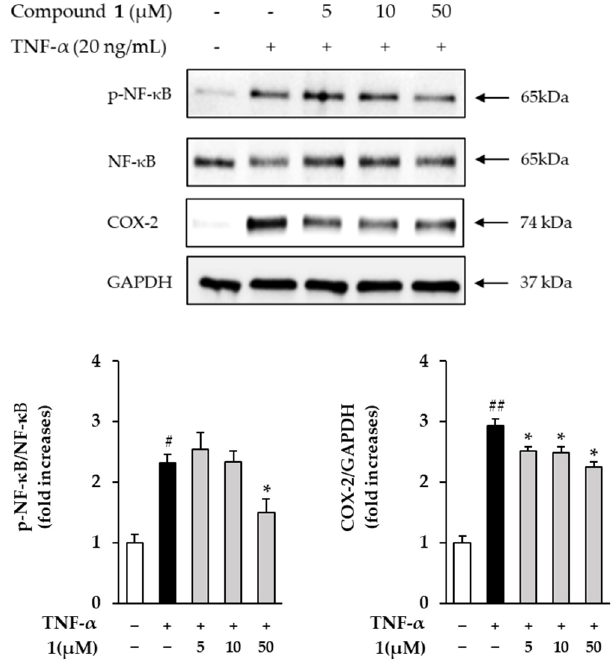
Figure 8. The effects of compound 1 on NF- κ B and COX-2 in TNF- α -treated HDFs. The cells were seeded on 6-well plate with the density of 3 × 10 5 cells/well and starved with non-serum media for 24 h. Next, before being exposed to 20 ng/mL TNF- α for 15 min and 6 h, the cells were treated with 5, 10 and 50 M of compound 1 for 1 h. Expression of NF- κ B, COX-2 and GAPDH were determined using Western blotting. The data were described as mean ± SEM. # p < 0.05 and ## p < 0.01 and non-treatment group versus TNF- α treatment group. * p < 0.05 sample treatment group versus TNF- α treatment group.